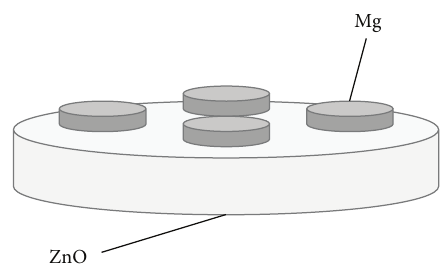
Figure 1: Schematic of the ZnO-Mg composite target.